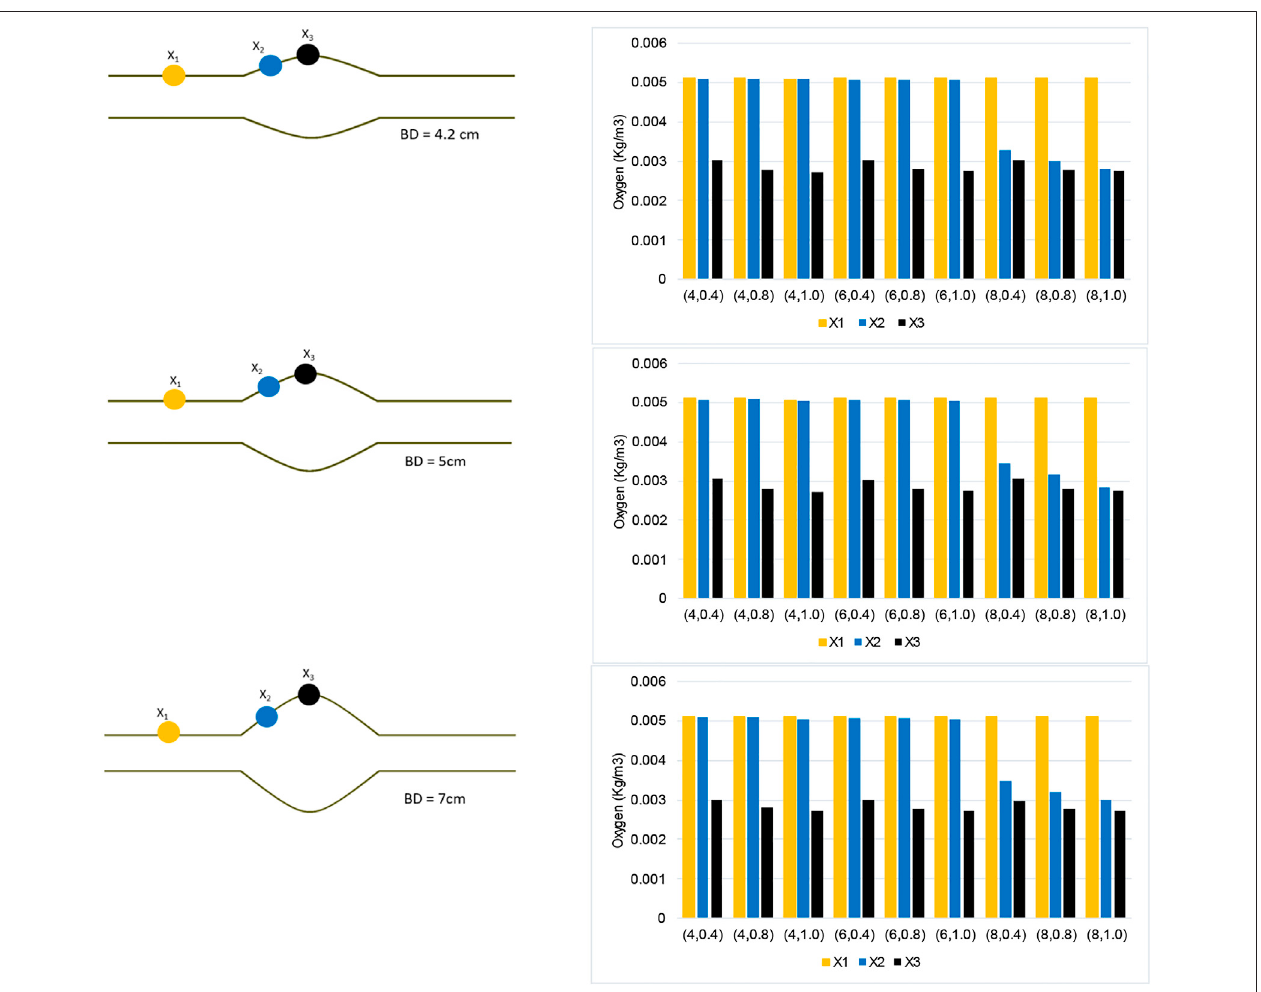
FIGURE10| OxygenconcentrationdatacollectedalongthreepointsoftheAAAmodelforeach case ( l , δ ) ,where l denotesILTlengthand δ isILTthickness. Plots corresponds to BD = 4.2 cm (top), BD = 5 cm (middle), and BD = 7 cm (bottom), respectively.